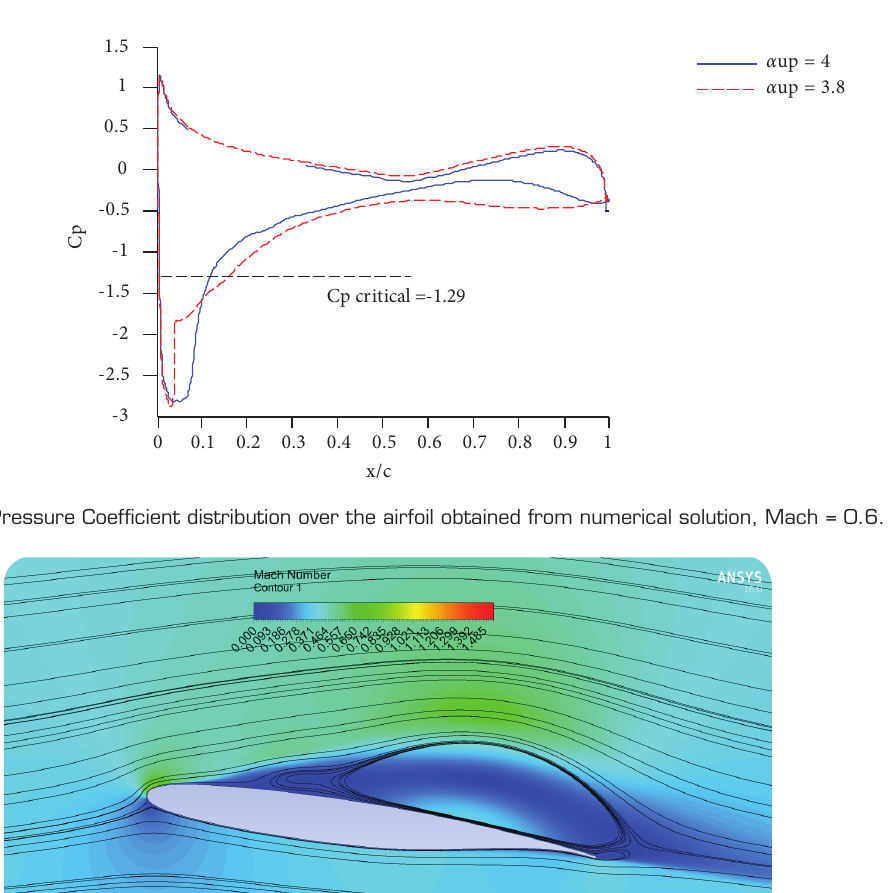
Figure 32. Mach contour, pitch motion α(t) = 3 + 3 sin( w t), frequency = 3 Hz, Mach = 0.4, Alpha = 5°.